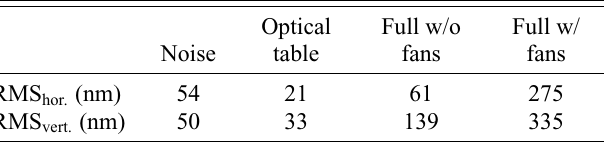
TABLE I. Root-mean-square (RMS) displacements over the full measurement bandwidth for vibration measurements shown in Fig. 10. Electronic background subtracted pointwise from